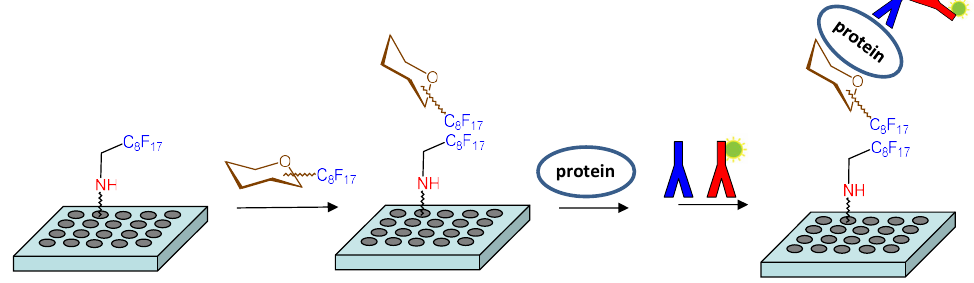
Figure 1. Schematic representation of the strategy used to study the interactions between fluorinated sugars and proteins on microtiter plates.